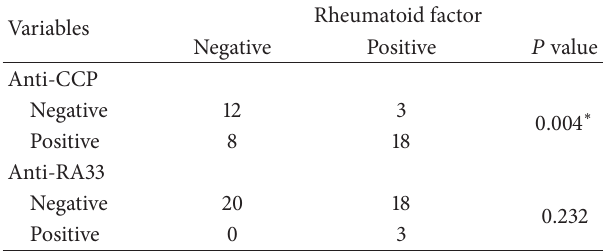
Table 4: Association of each of the autoantibodies with RF.